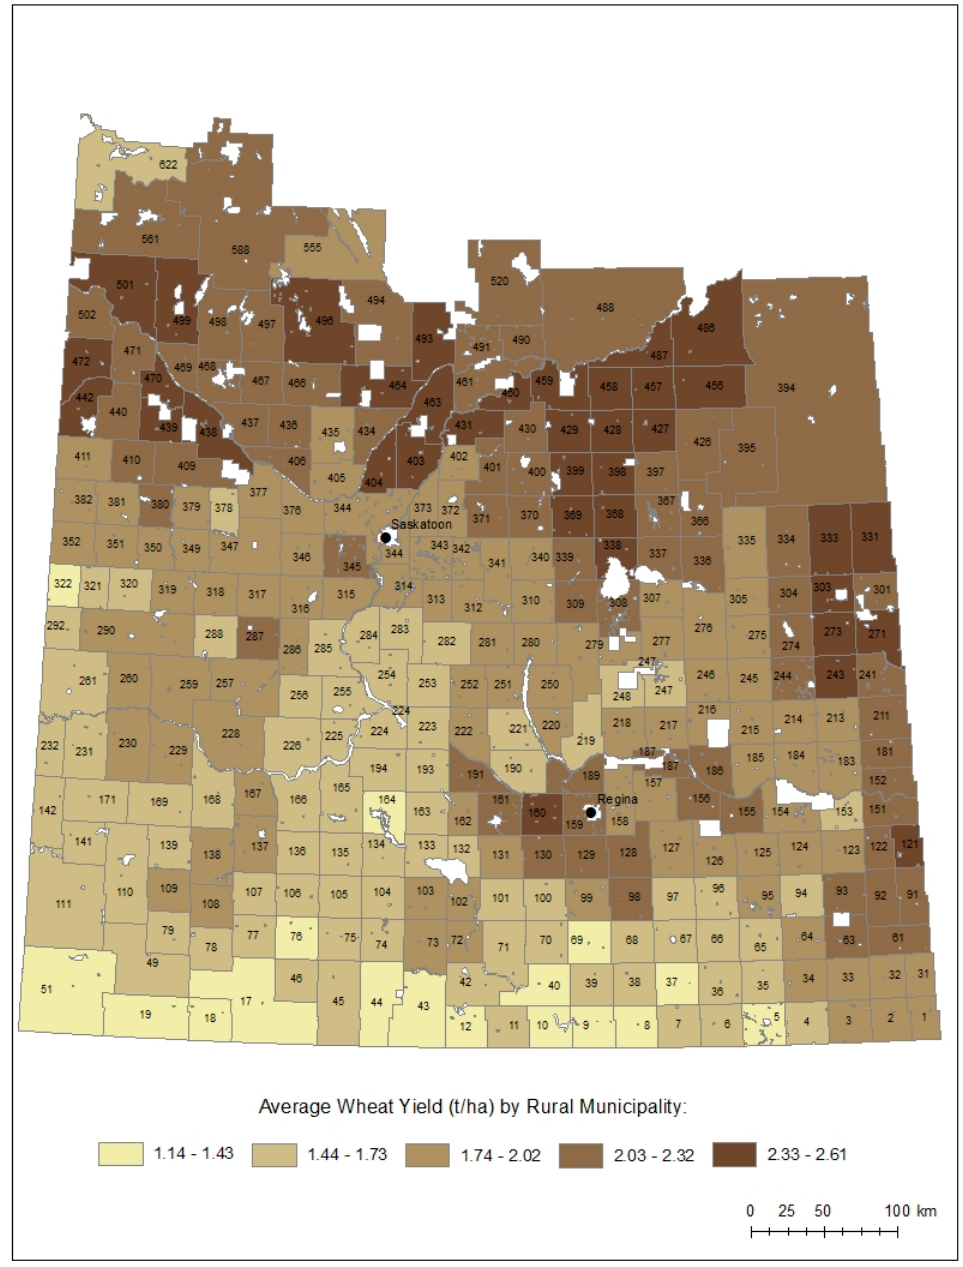
Figure 4. Average wheat yield (t/ha) by rural municipality (RM) (1979–2016).